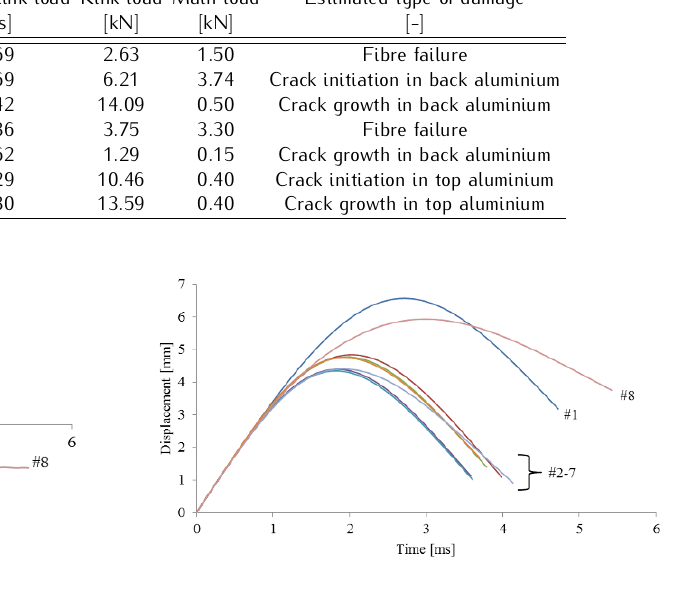
Figure 9. Recorded displacement-time curves. plots #2-7 than for #1 and #8. The analogous shape of #2-7 indicates that the glass/epoxy plies are dominating the flexural behaviour at these impact stages while #1 and #8 with larger permanent flexure demonstrate that plastic deformation occurred in the aluminium layers. In comparison with Figure 5, the higher the stiffness, the sooner the maximum displacement becomes.